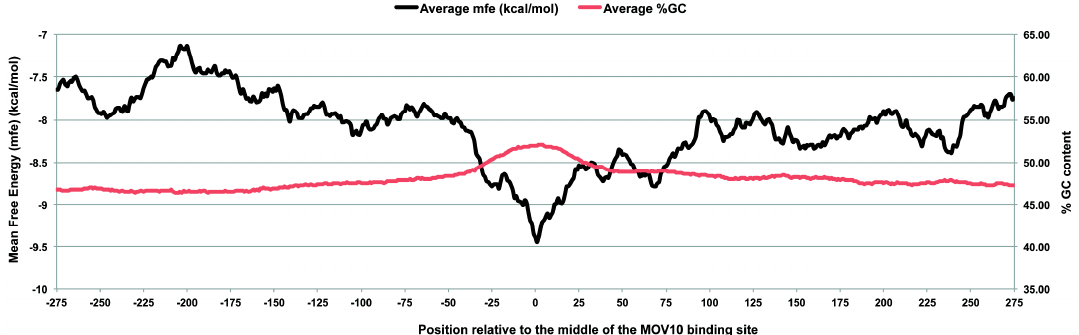
Figure 2. Global analysis of Moloney leukemia virus 10 (MOV10) CLIP sites in the 3 ′ UTR show an elevated G-rich secondary structure. Mean free energy plot of MOV10 3 ′ UTR iCLIP sites. Mean free energy of folding Δ G folding was calculated across 55 nt windows ± 275 nt from center of iCLIP site (black). Guanine-cytosine (GC) content (%) is plotted in red [49]. MOV10 was first identified as being associated with RISC when it was found to be required for miRNA reporter cleavage and co-localized with AGO2 in P-bodies [63]. A study of MOV10 and AGO2 bound mRNA found a high degree in shared mRNA targets and MOV10’s interaction with AGO2 was RNA-dependent [62]. Recent CLIP-seq studies also indicate a high mRNA target correlation with AGO2 targets, and that AGO2’s association with target mRNA is perturbed in the absence or overexpression of MOV10 [50]. The consquence of these interactions on mRNA fate through the miRNA pathway is discussed below.